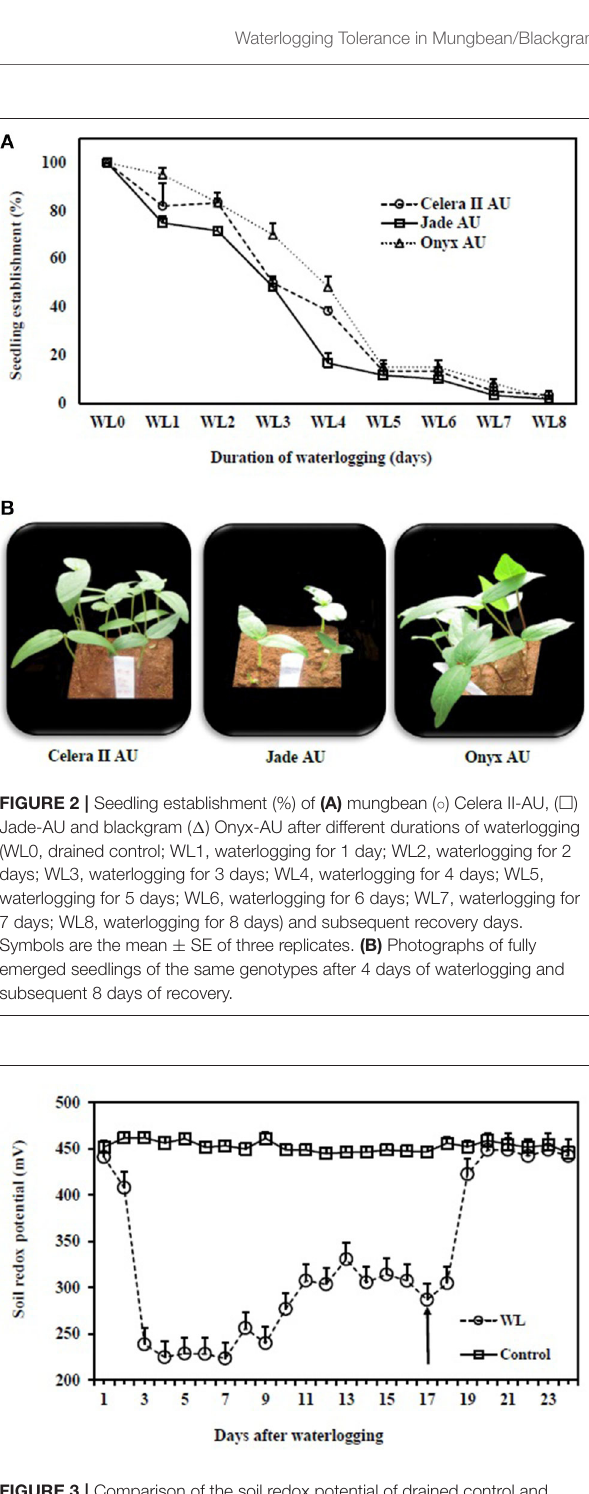
parameters except nodulation score and maximum taproot depth ( Table 3 ). The effects of waterlogging duration, genotype, and their interaction were significant for all